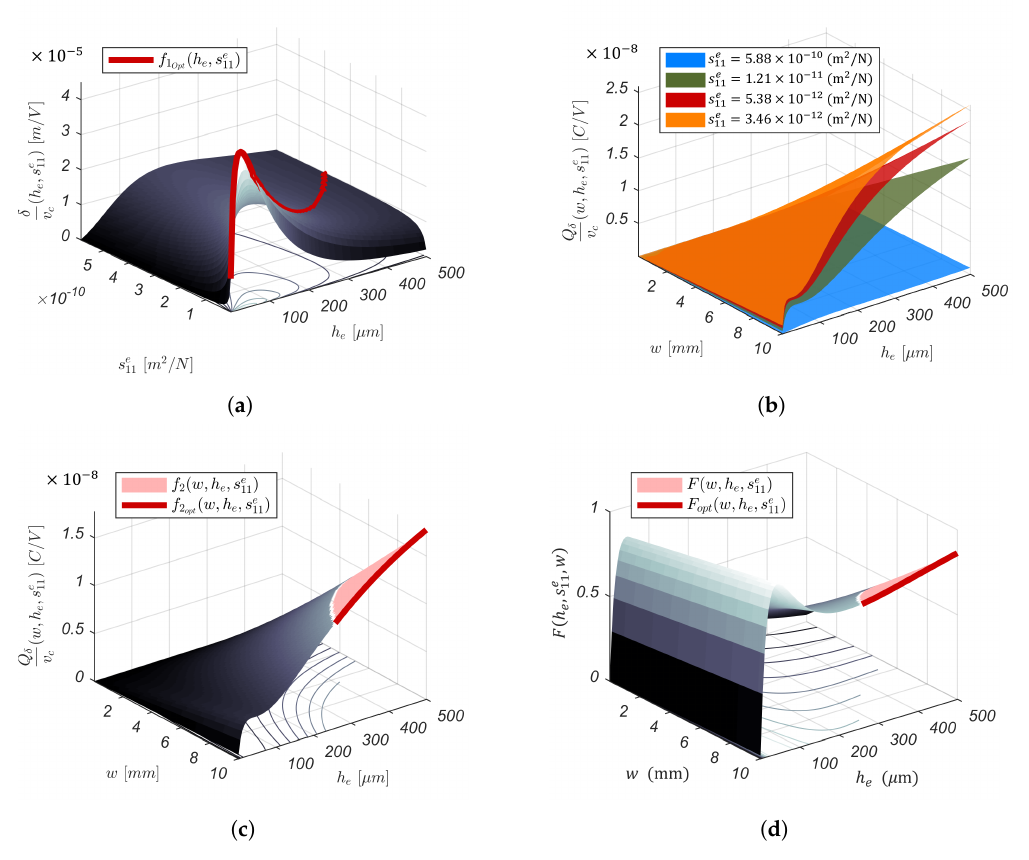
Figure 4. Geometric parameters and material properties’ dependence. ( a ) Piezoelectric actuation. ( b ) Piezoelectric sensor’s sensitivity to strain induced by piezoelectric actuation for Cs , Ag , Ta , as Cr as the elastic layer of the bender. ( c ) Piezoelectric sensor’s sensitivity to strain induced by piezoelectric actuation for Ag as the elastic layer of the bender. ( d ) Simultaneous sensing and actuation: ”Self-Sensing”.